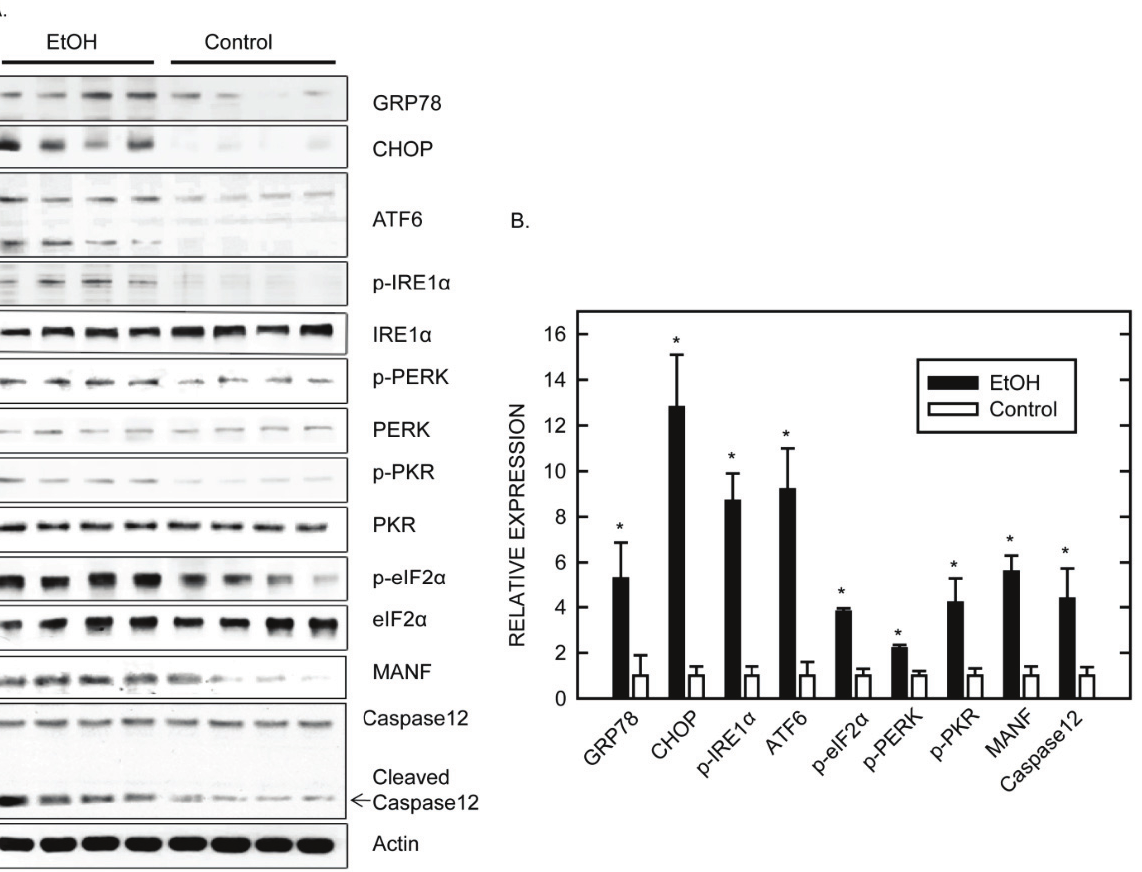
Figure 1. Ethanol induces ER stress in the developing brain, adapted from data published by Ke, Z. et al. [5]. ( A ) mice of postnatal day seven (PD7) were subcutaneously injected with ethanol (2.5 g/kg) or saline at time 0 and 2 h. Eight hours after the first injection, the cerebral cortex was harvested and the expression of ER stress markers was analyzed with immunoblotting. N = 4 for each group; ( B ) The protein expression was quantified by densitometry, normalized to the level of actin and presented as mean ± SEM